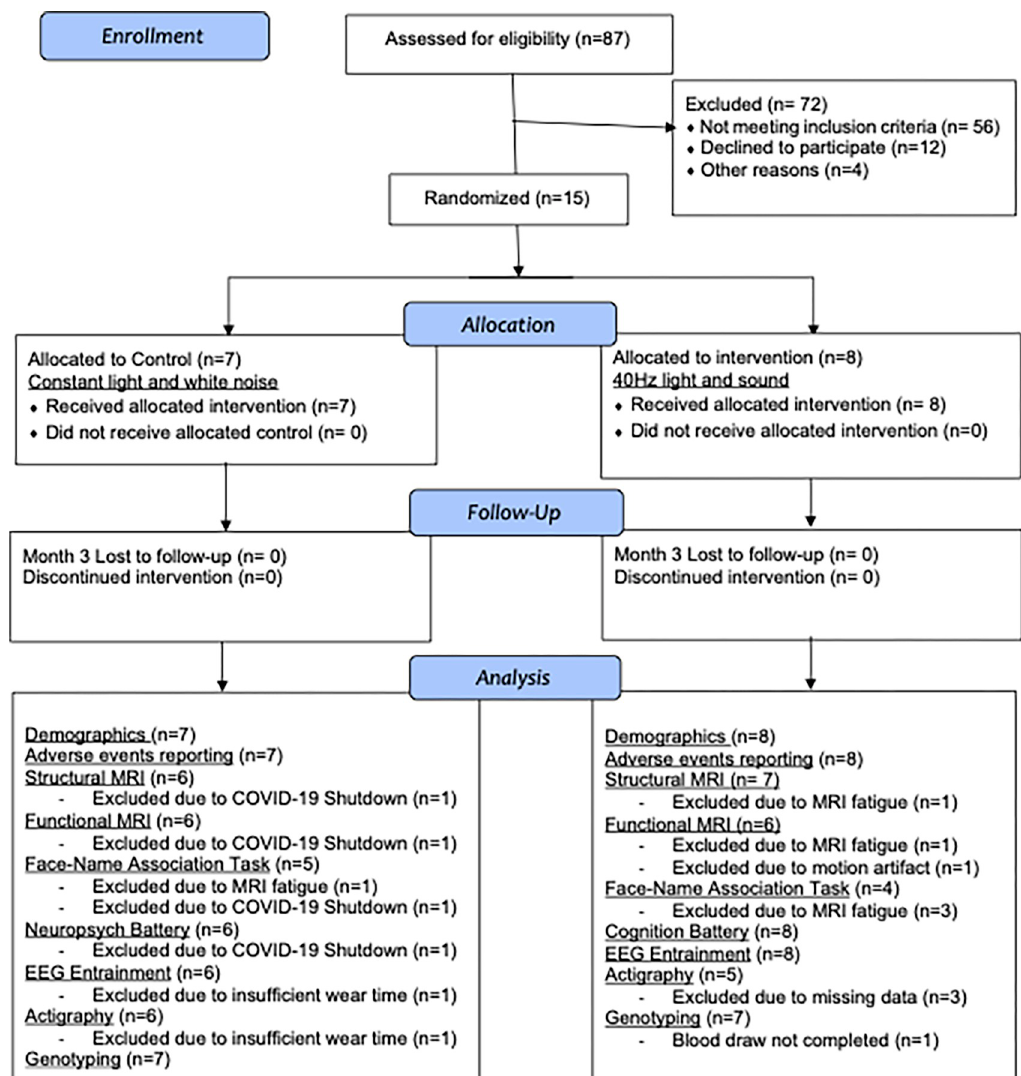
Fig 1. CONSORT flow diagram: Phase 2A study cohort. Participant recruitment, allocation, follow-up, and analysis counts by activity.